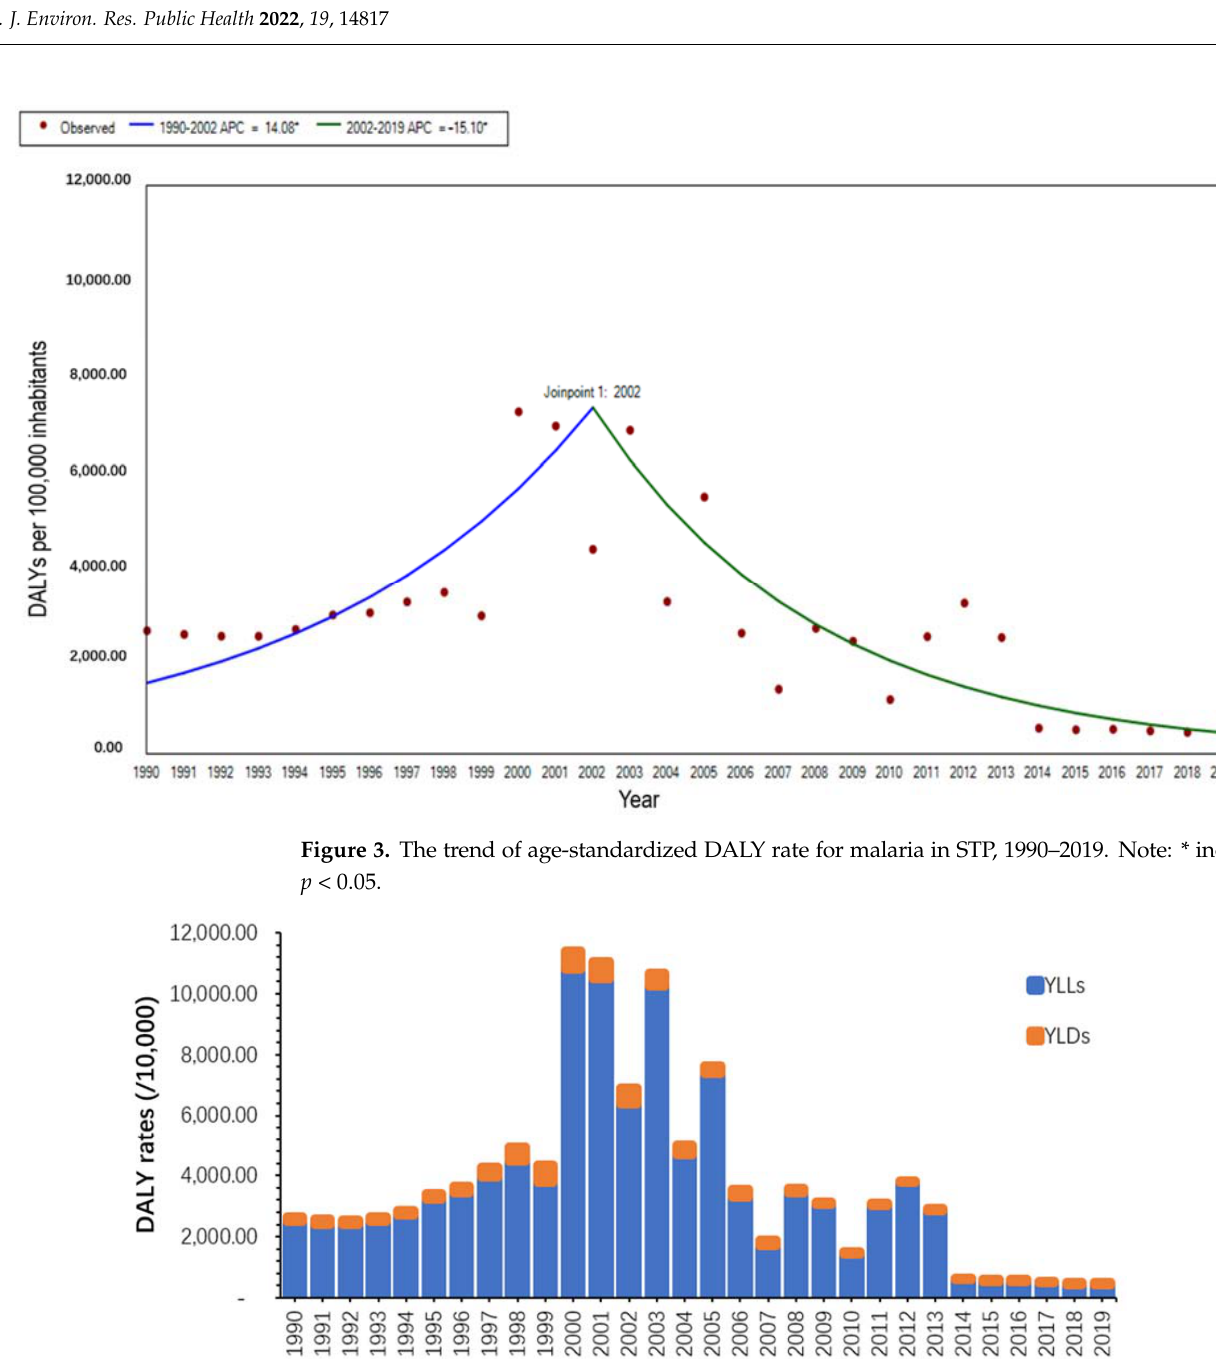
Figure 4. Total YLD rate and YLL rate per 100,000 (DALYs) in STP, 1990–2019.